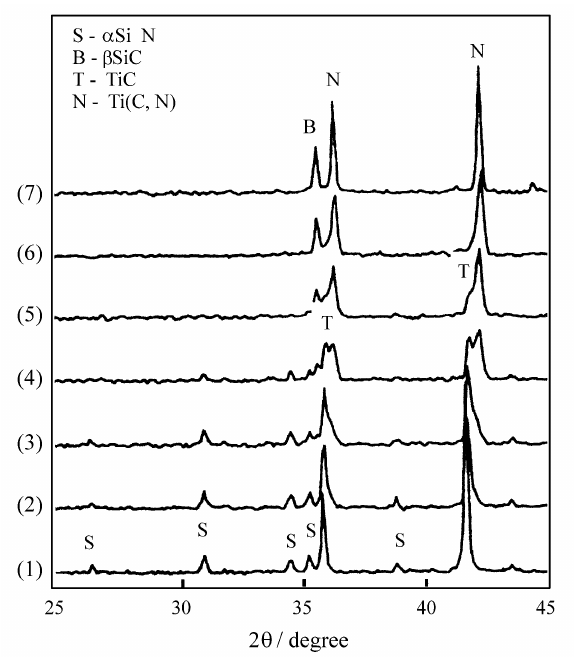
Figure 3. Diffractogramms taken from the TiC:Si 3 N 4 = 4:1 mixture (1) before the heat treatment and after heat treatment at (2) 1300 °C, (3) 1400 °C, (4) 1500 °C, (5)1600 °C, (6) 1700 °C, and (7) 1750 °C, respec-